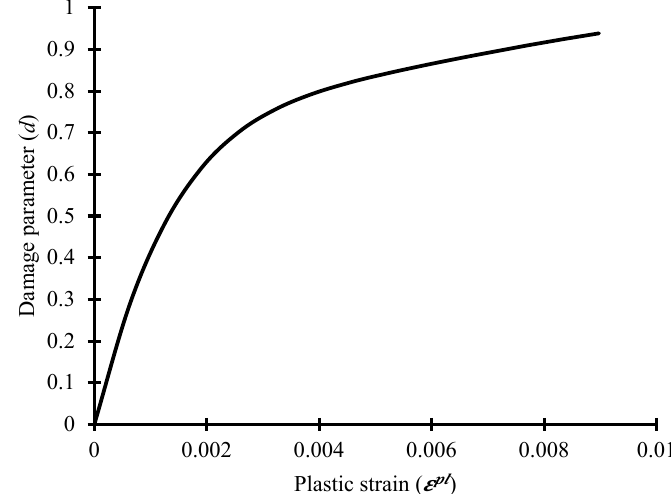
Figure 3. Concrete tension damage vs. cracking strain.